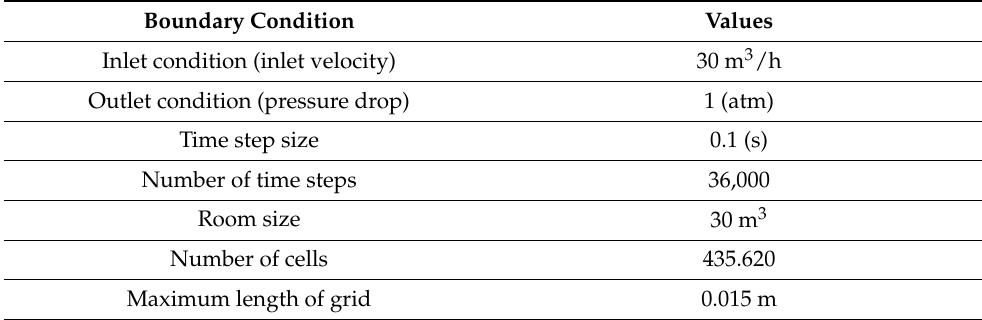
Table 3. Discrete particle method (DPM) parameters for simulation.